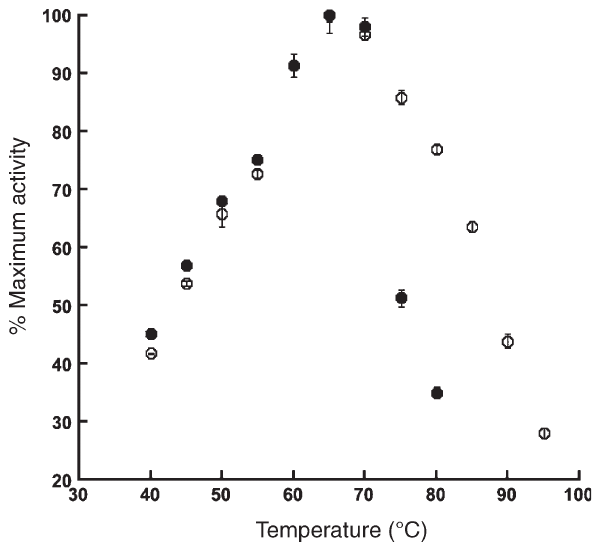
Figure 3. Divalent metal specificity for MT1-ACS and AF-ACS2. En- zymereactionswere performedintriplicateat65 °C inthepresenceof 20 mM metal (as the chloride salt) +20 mM ATP. Activities are re- ported as a percentage of the maximum activity determined for each enzyme with Mg 2+ as the metal substrate.